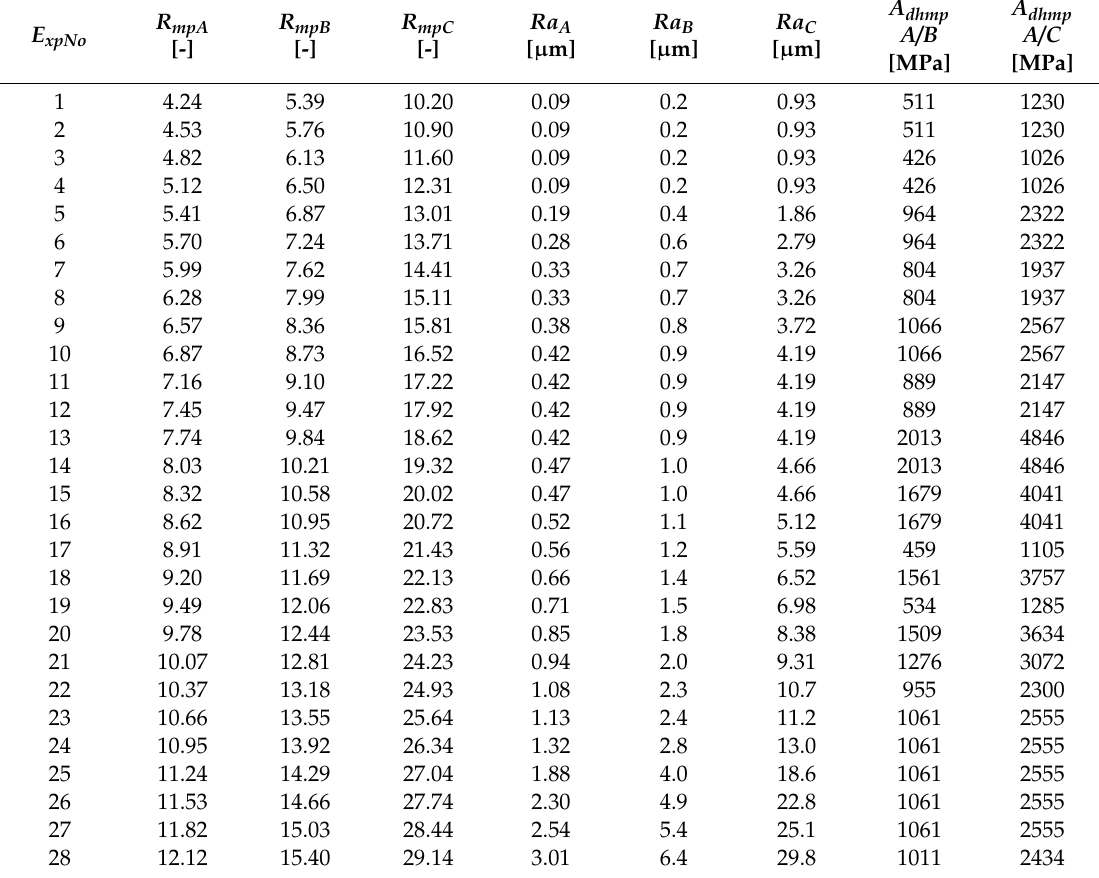
Table 6. Selected, measured and calculated parameters for the number of experiments E xpNO =